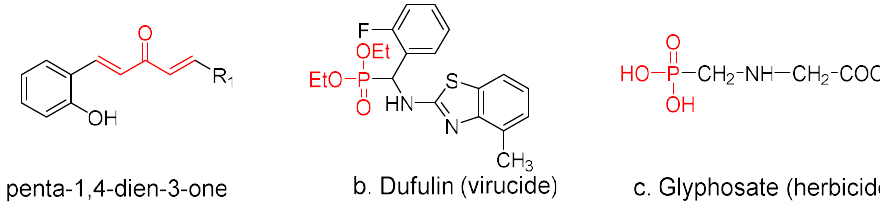
Figure 1. The structures of penta-1,4-dien-3-one and some commercial drugs.